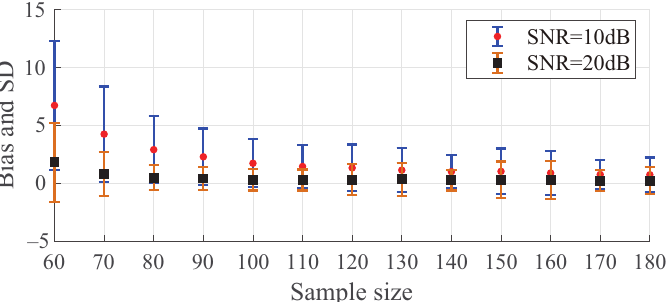
Figure 4. Bias and SD of bandwidth detection with different sample sizes when K =